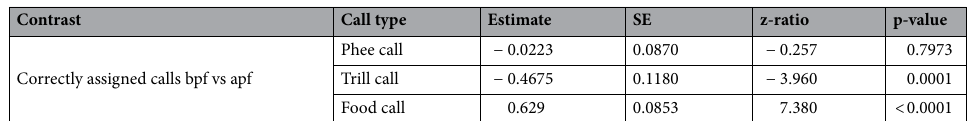
Table 4. Post hoc tests reveal that while trill calls are significantly less likely to be correctly assigned to the correct individual after pair formation than before, the probability of correctly assigning food calls to the correct individual is higher after pair formation than before. There was no difference in correct assignment to be found in phee calls. p-values are Tukey HDS corrected to take multiple testing into account.